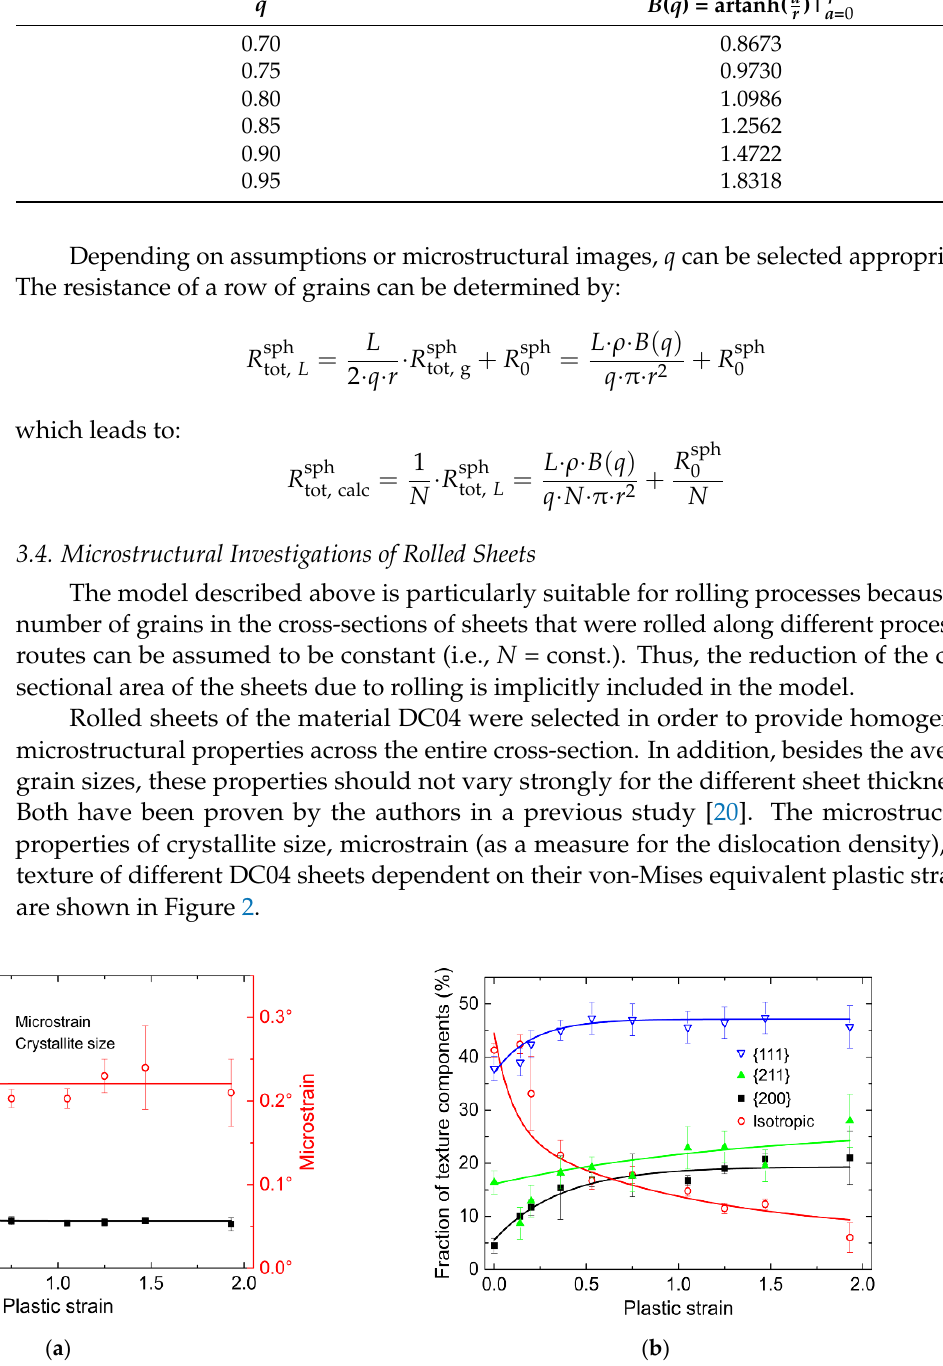
Table 1. Solution of the integral in Equation (7) for different values of q .